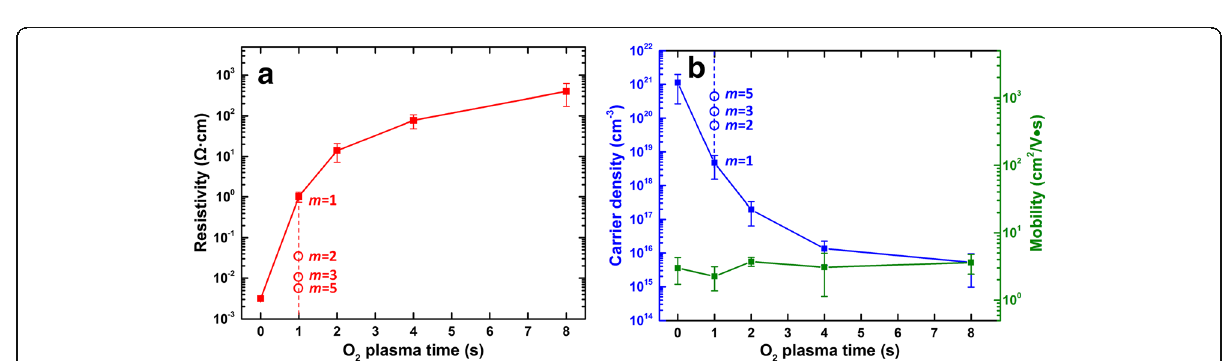
Fig. 3 a Electrical resistivity of ZnO films grown from different O 2 plasma times with fixed thermal cycle m (solid dots) and different thermal cycles with fixed O 2 plasma time (open dots) by the supercycled ALD process. b Carrier concentration (blue) of ZnO films grown from different O 2 plasma times with fixed thermal cycle (solid dots) and different thermal cycles with fixed O 2 plasma time (open dots). Mobility (green) of ZnO films grown from different O 2 plasma times with a fixed thermal